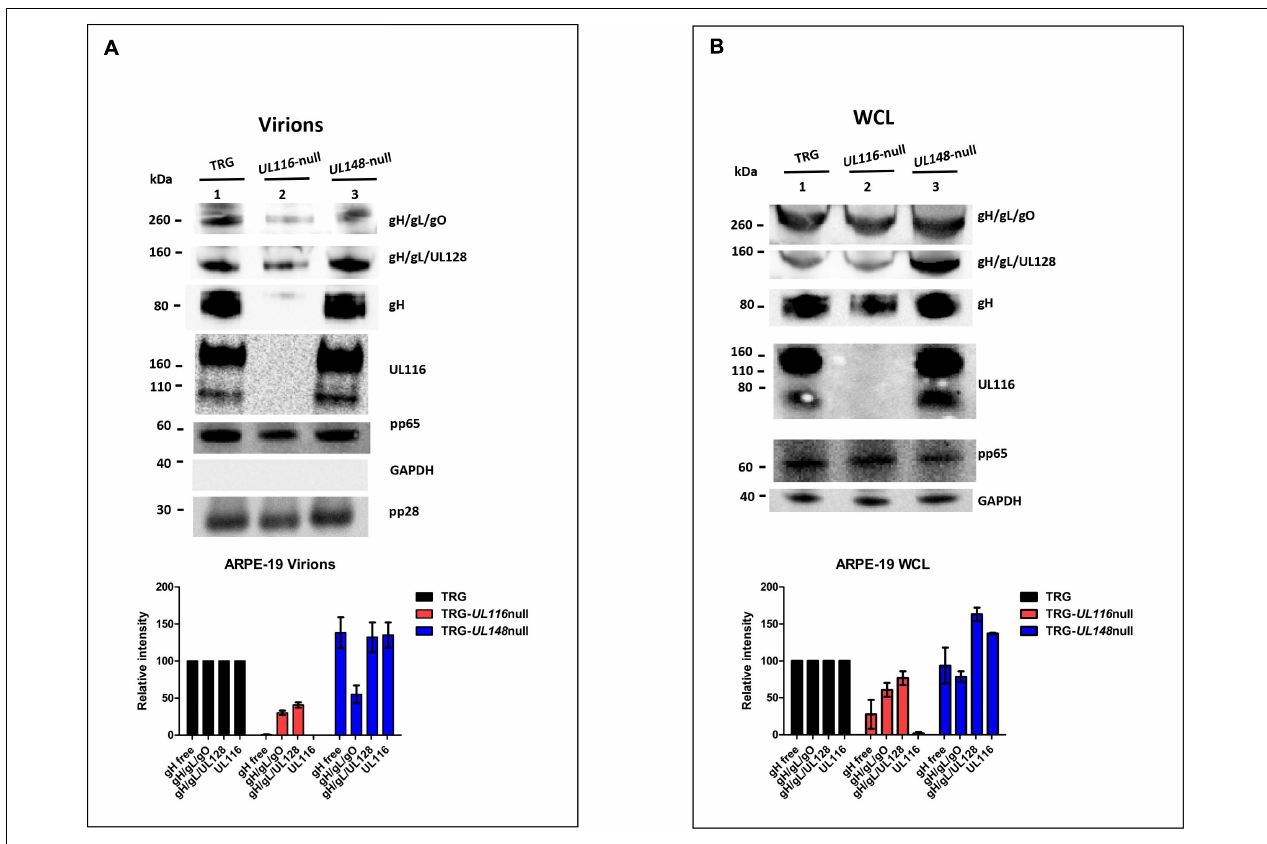
FIGURE 4 | Loss of UL116 or UL148 gene products alters the ratio of gH/gL complexes in ARPE-19 cellular extracts and virions. Analysis was performed as specified in the legend of Figure 3 . Viruses used for infection are indicated at the top of each lane. (A) Immunoblots of lysates from sucrose cushion-purified virions (8 DPI; B ) Equal amount of total proteins (quantified by BCA) from 10 DPI whole cell lysates (WCL) of ARPE-19 infected with the viruses indicated on the top of the figure were separated on 4–12% PAGE-SDS (NuPage, Invitrogen) and treated for western blot analysis. Graphs reported at the bottom of the figure were generated with values of three independent experiments with statistical